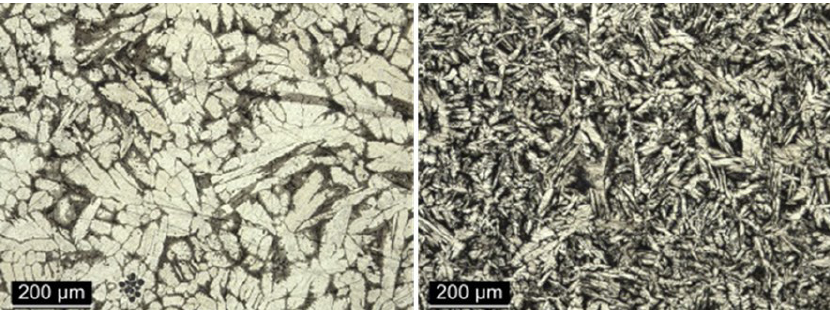
Figure 5. Optical images of both NAB samples for NAB alloy A (left) and NAB alloy B with Ti (right) (scale bar 200 µm) with their corresponding difference in the grain size and size fraction areas of